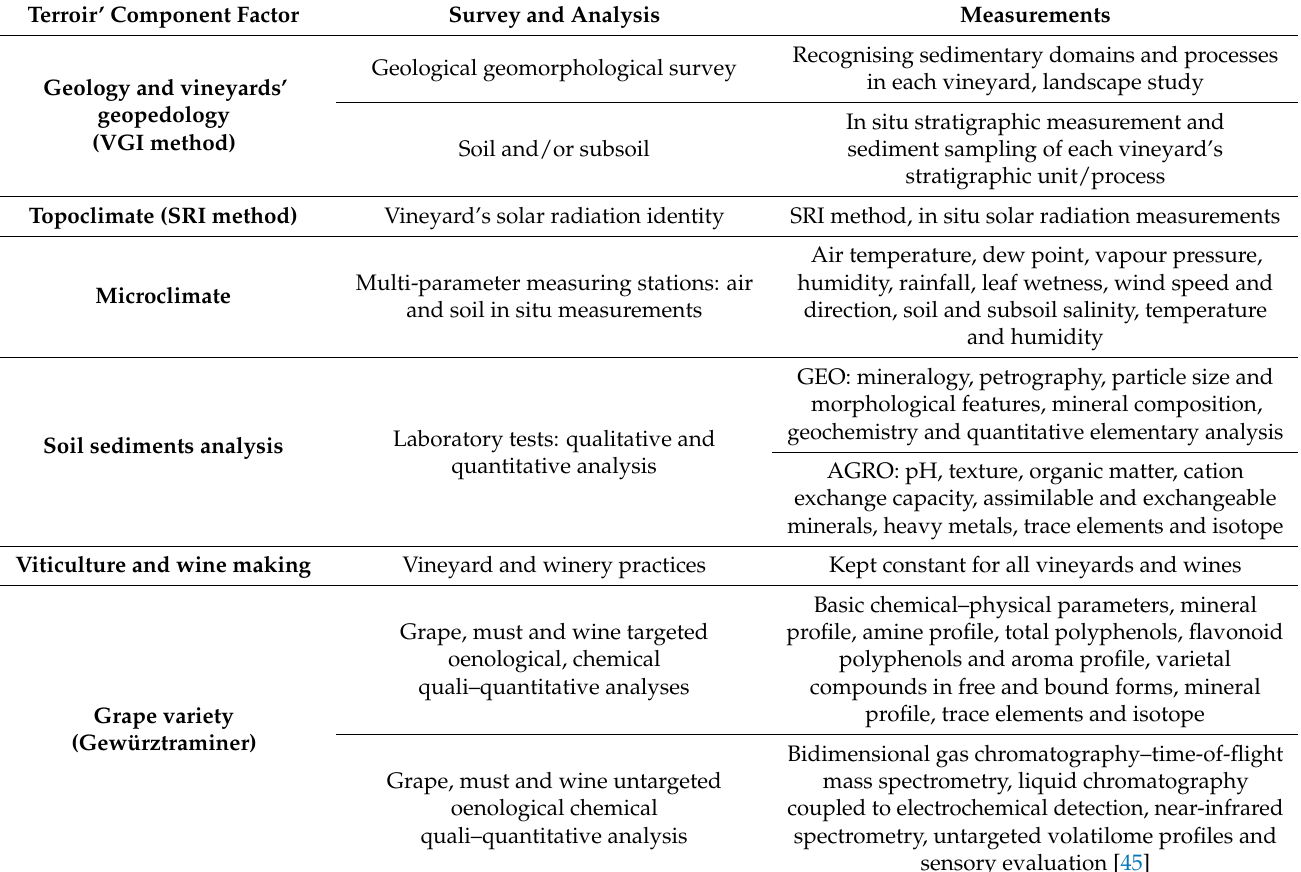
Table 1. Summary of the surveys and measurements of a terroir’s component factors adopted in the